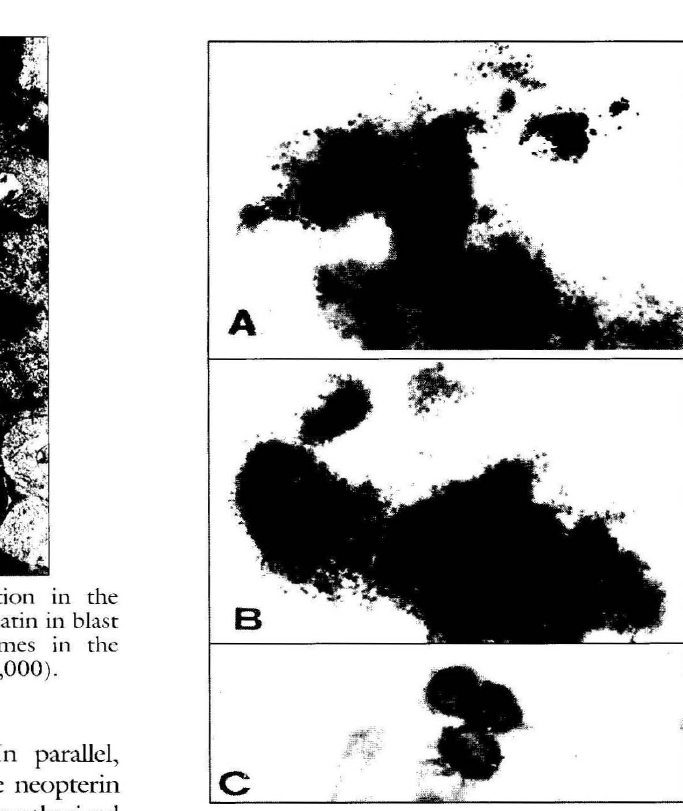
Figure 7. Nitric oxide synthase (NOS) activity in the cytoplasms of murine peritoneal macrophages-activated after in vivo treatment by the ranopterin-neopterin (A, B); NOS-positive small- and medium-sized bone marrow macrophages following intravital treatment by neopterin. (Hope and Vincent method, 1989, in our modification; x